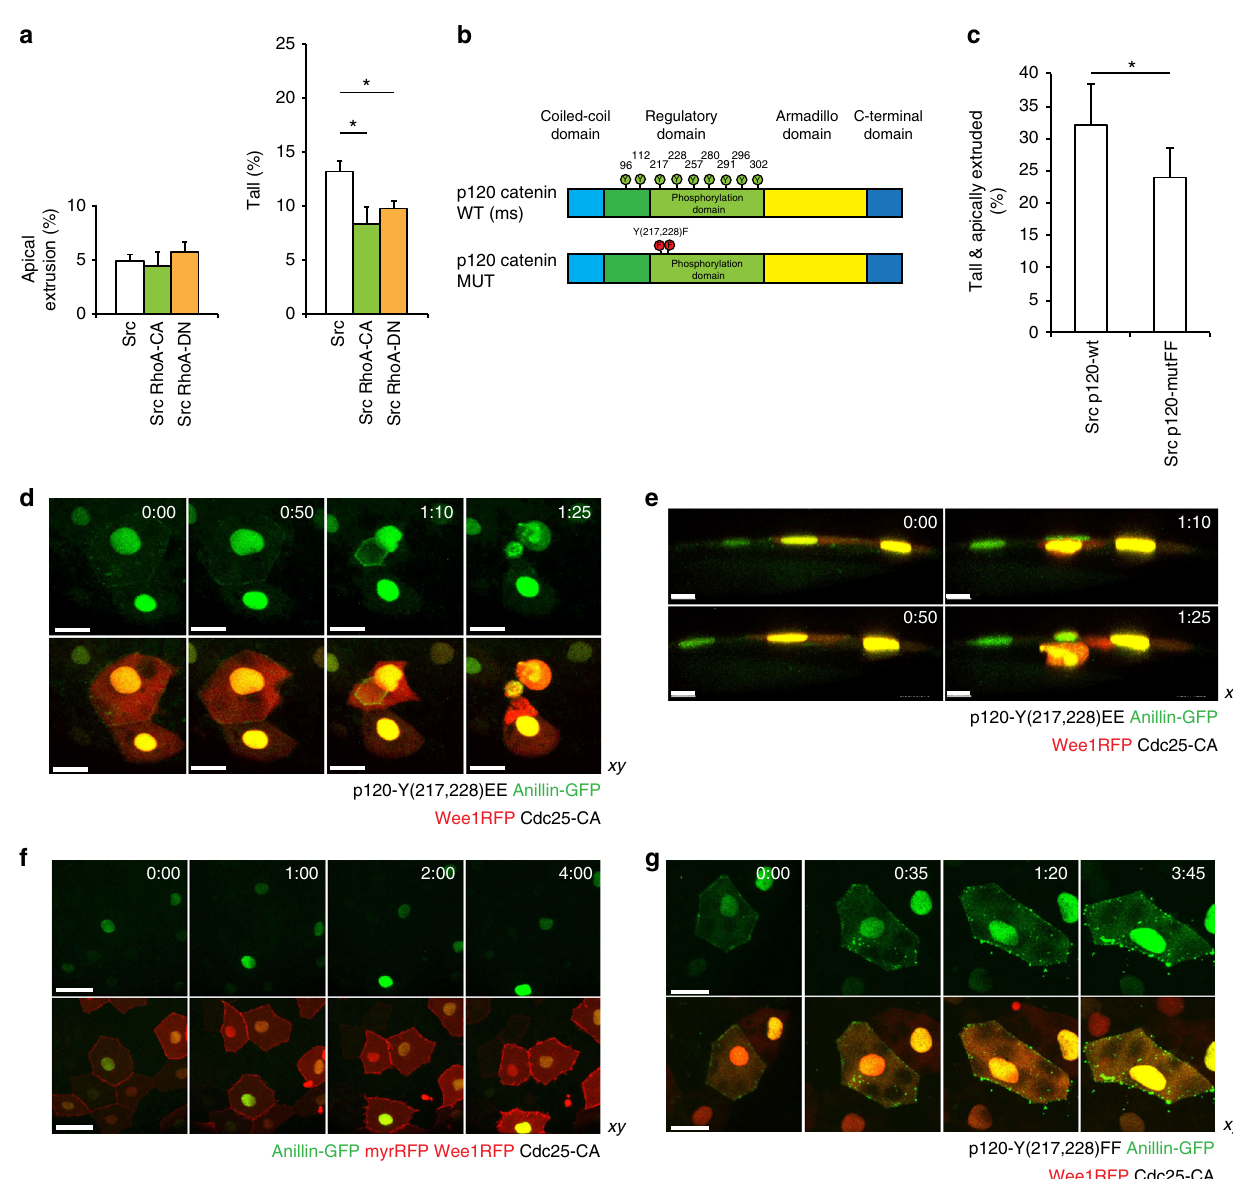
Fig. 7 Src-phosphorylated p120-catenin recruits Anillin to the junctions. a The effect of constitutively active and dominant negative RhoA on vSrc-driven extrusion. Embryos were injected with the following constructs: dUAS:EGFP-vSrc, dUAS:EGFP-vSrc;CA-RhoA or dUAS:EGFP-vSrc;DN-RhoA. The two graphs display cells Apically extruded (outside of the embryo) and Tall (within the monolayer but taller than neighbours). Data are mean ± s.d. of 3 independent experiments (total number of embryos: n Src = 35; n Src,CA-RhoA = 38; n Src,DN-RhoA = 36). * P < 0.05 (Student ’ s t -test). b A schematic model of the domain composition of p120-catenin. In green are phosphorylation sites regulated by the Src kinase (from: PhosphoSitePlus database). In the bottom panel, a design of p120-catenin mutant with two sites regulating the interaction between p120-catenin and RhoA 44 . These sites are mutated from Y to F (p120-mutFF). c The effect of phosphomimetic p120-mutFF on vSrc-driven extrusion. Embryos were injected with the following constructs: dUAS:EGFP- vSrc;p120-wt or dUAS:EGFP-vSrc;p120-mutFF. Data are mean ± s.d. of three independent experiments (total number of embryos: n Src,p120-wt = 34; n Src,p120- = 42). * P < 0.05 (Student ’ s t -test). d , e Time-lapse imaging of the effect of phosphomimetic p120-mutEE on the localisation of Anillin-GFP in cells mutFF arrested at the G2/M transition. Embryos were injected with a combination of the following constructs: dUAS:Cherry-Wee1;CA-Cdc25 and dUAS:p120- mutEE;Anillin-GFP. Movies were taken over 4 h. Frames were extracted from a representative movie at indicated times from the tailbud stage in xy ( d ) and xz ( e ) view. Scale bars, 40 µ m ( d ) and 20 µ m ( e ). f Time-lapse imaging of Anillin-GFP localisation in cells arrested at the G2/M transition. Embryos were injected with a combination of the following constructs: dUAS:Cherry-Wee1;CA-Cdc25 and dUAS:myr-Cherry;Anillin-GFP. Movies were taken over 4 h. Frames were extracted from a representative movie at indicated times from the tailbud stage. Scale bars, 50 µ m. g Time-lapse imaging of the effect of p120-mutFF on the localisation of Anillin-GFP in cells arrested at the G2/M transition. Embryos were injected with a combination of the following constructs: dUAS:Cherry-Wee1;CA-Cdc25 and dUAS:p120-mutFF;Anillin-GFP. Movies were taken over 4 h. Frames were extracted from a representative movie at indicated times from the tailbud stage. Scale bars, 25 µ